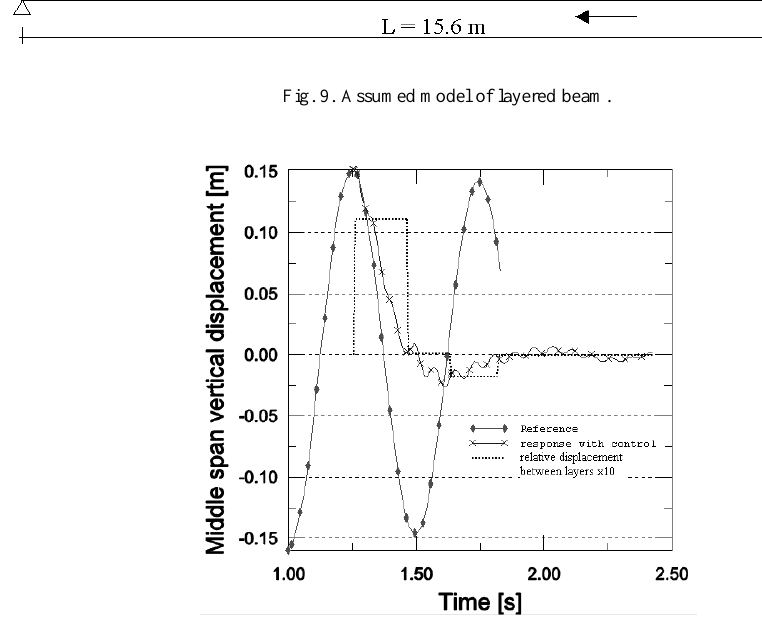
Fig. 10. Vertical displacement of the middle of